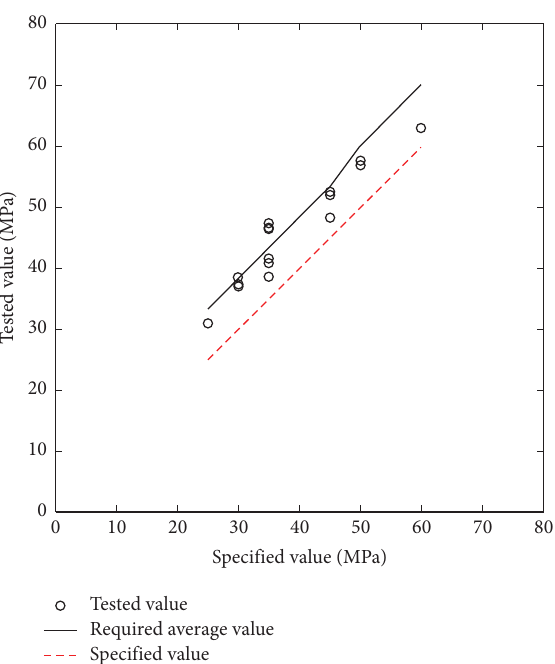
Figure 3: Te compressive strength of